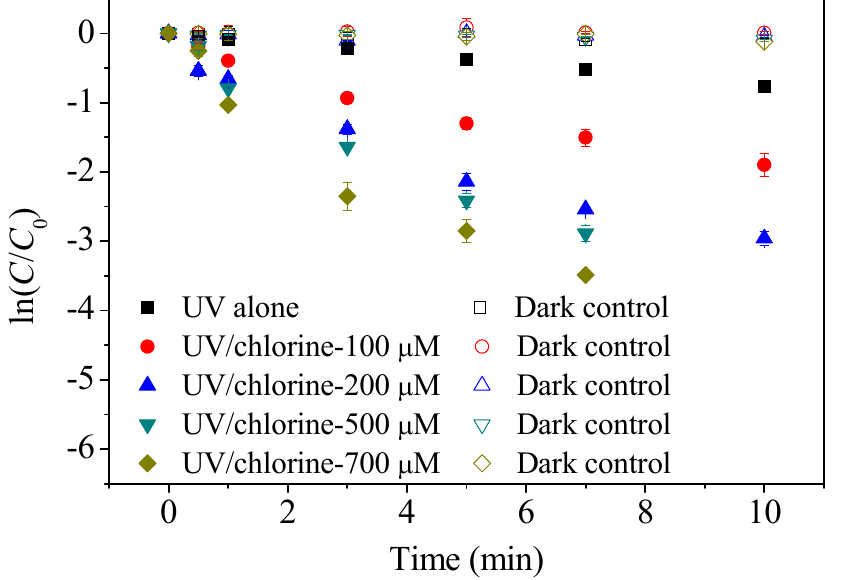
Figure 1. Degradation kinetics of CTZ in UV/chlorine system with different concentration of free chlorine (pH = 7.0, [CTZ] 0 = 10 µM. The error bars represent the 95% confidence interval ( n = 3)).